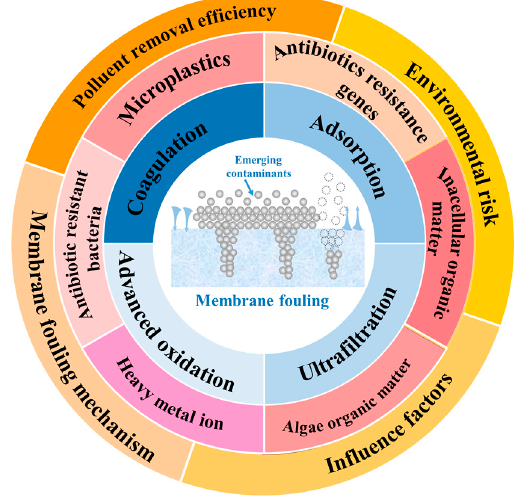
Figure 1. Schematic of the uses of pretreatment processes to reduce membrane fouling.